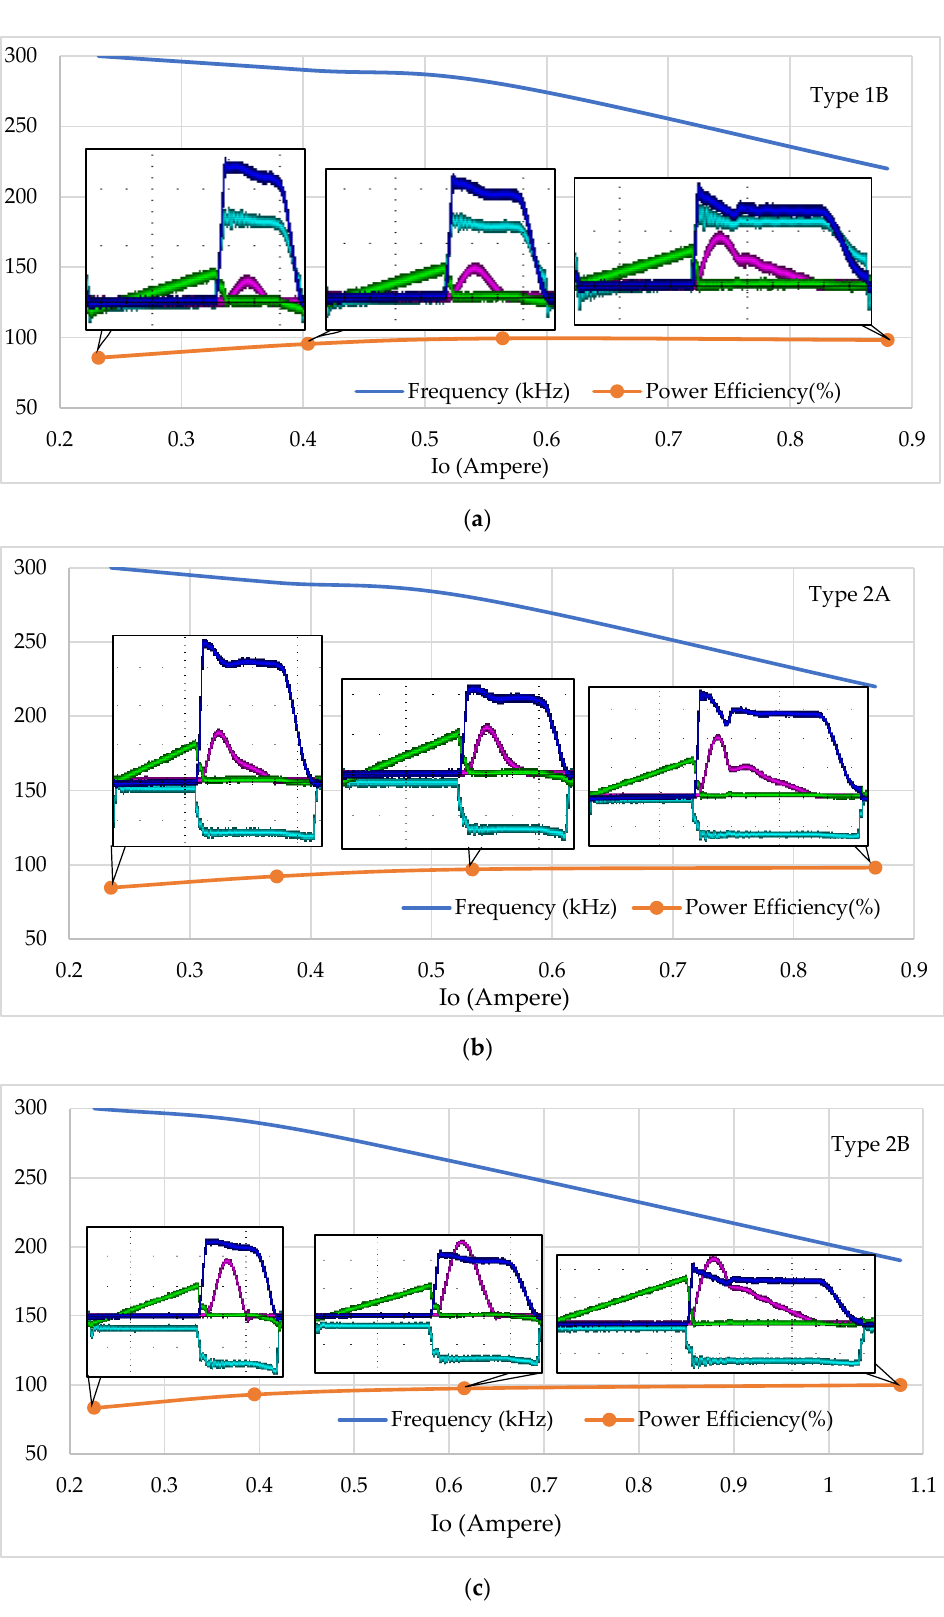
Figure 13. Comparison of zero-current switching of DCM on different types of cascode arrangements. ( a ) Type 1B; ( b ) Type 2A; ( c ) Type 2B.